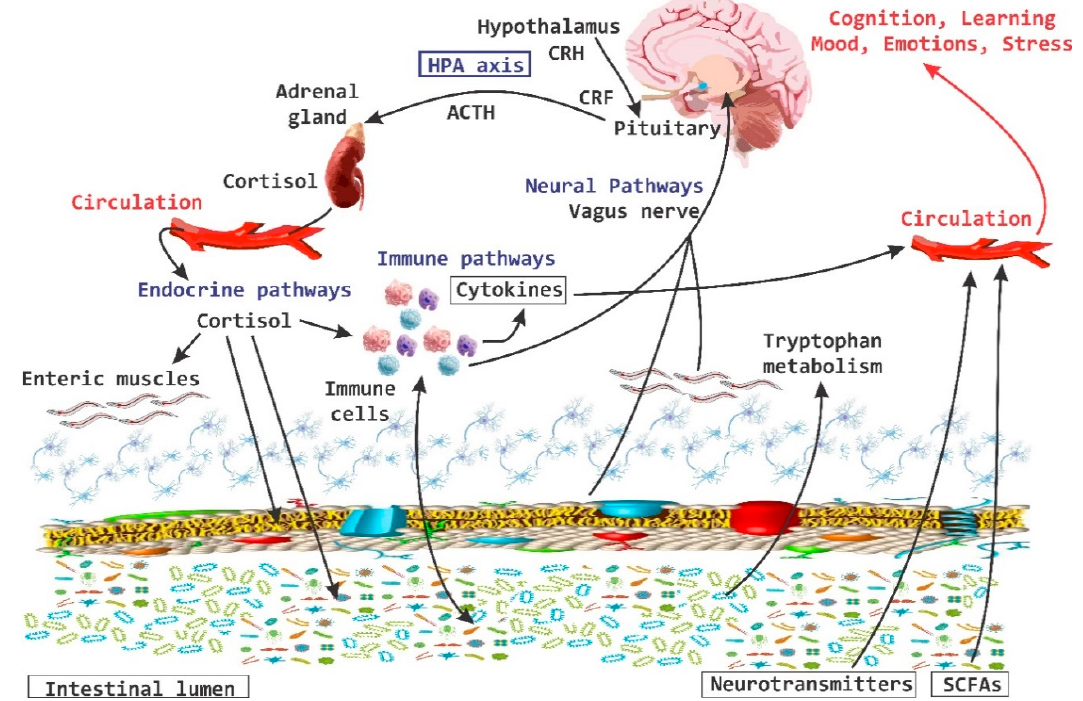
Figure 2. Brain-Gut Axis. The brain-gut axis is essential for the regulation established between the intestine and the brain. It includes the central nervous system and the endocrine and neuroimmune systems; as well as the enteric nervous system. CRH, corticotropin-releasing hormone; CRF, corticotropin releasing factor; SCFAs, short chain fatty acids; ACTH, adrenocorticitropic hormone; HPA, hypothalamic pituitary adrenal.